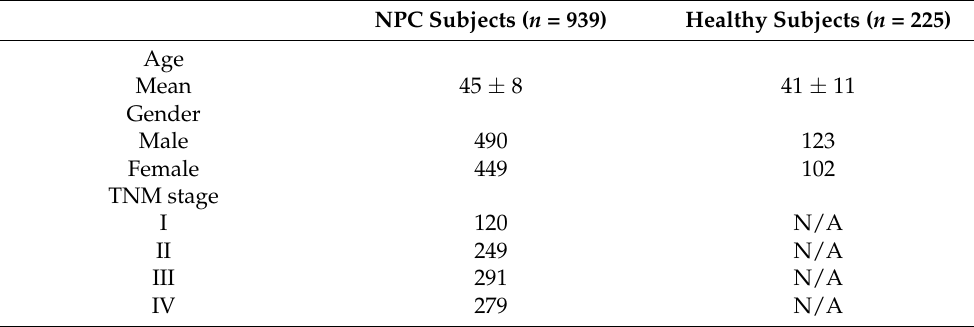
Table 1. Clinical information on NPC and healthy